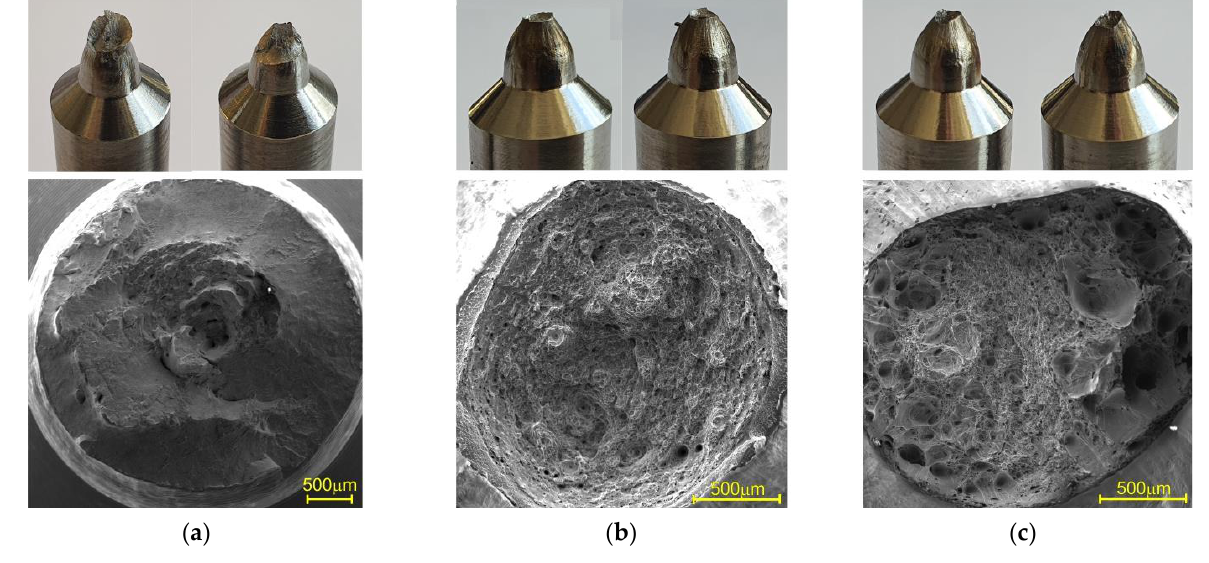
Figure 7. Fracture surface of specimens tested at ( a ) 200 °C, ( b ) 500 °C, and ( c ) 700 °C. Deep dimples are clearly visible in the central region of the fracture surfaces of the